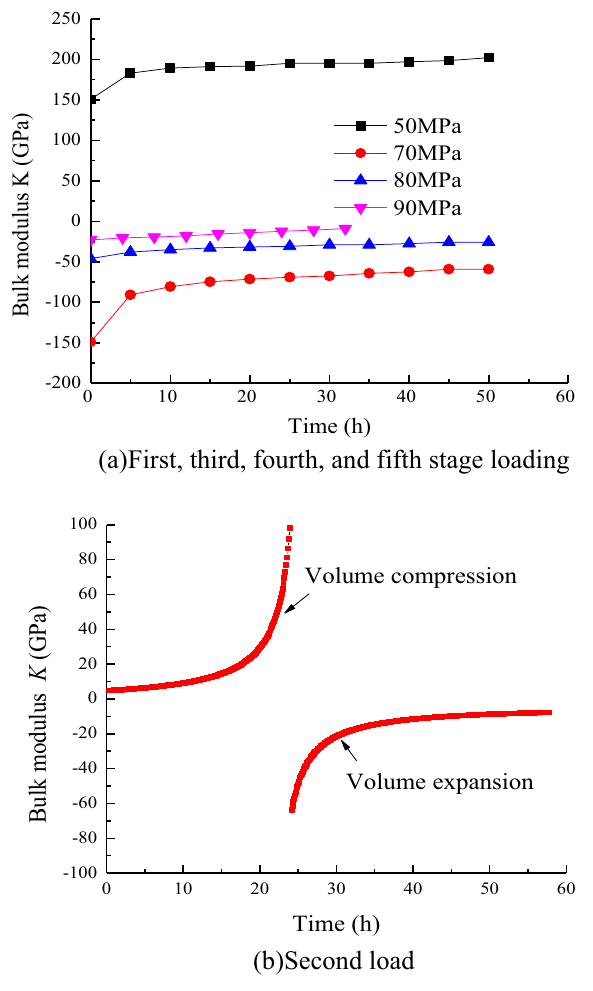
Figure 10. Duration of creep and bulk